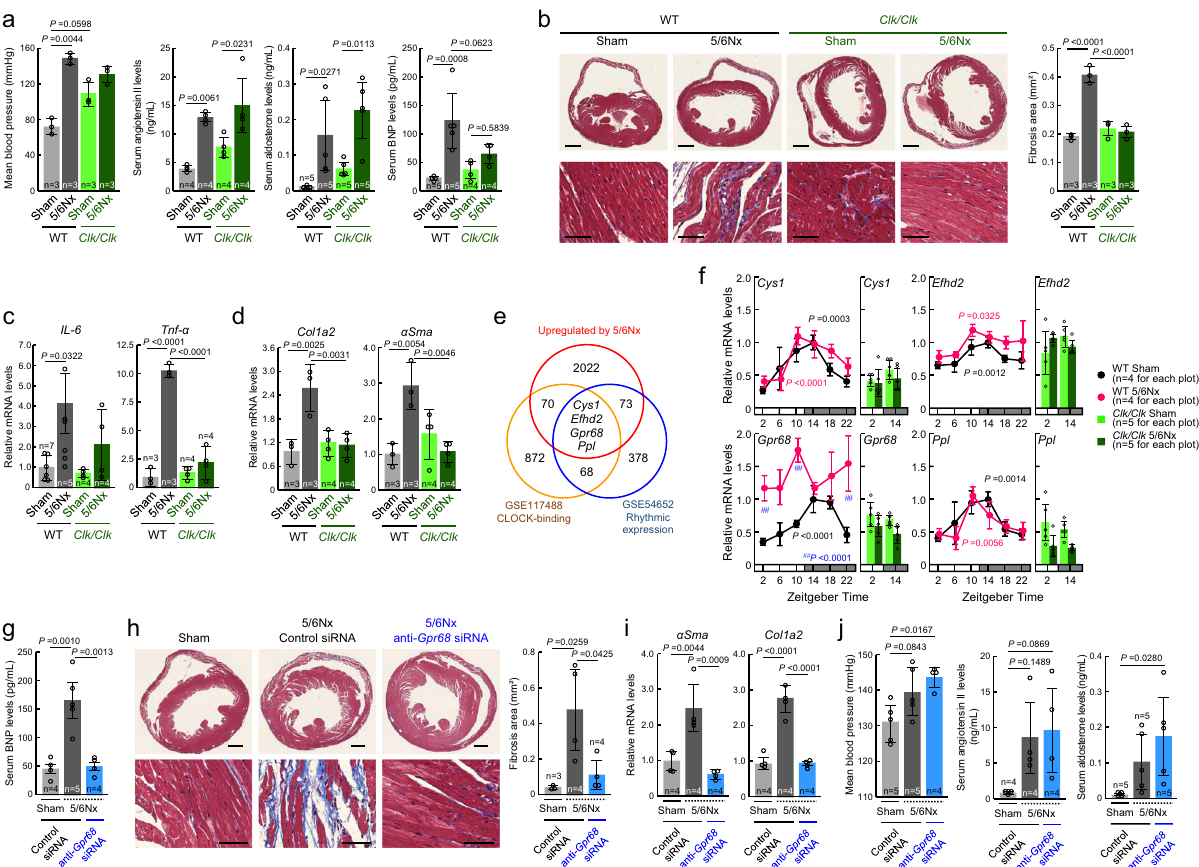
Fig. 1 Mutation of Clock gene suppresses cardiac complications in 5/6Nx mice. a Blood pressure and serum concentrations of angiotensin II, aldosterone, and BNP in wild-type (WT) and Clk/Clk mice with 5/6Nx. b Masson ’ s trichrome staining of fi brosis (blue) in the cardiac ventricle of WT and Clk/Clk mice with 5/6Nx. The right panel shows the quanti fi cation of the fi brosis area under light microscopy. c , d The mRNA levels of IL-6 , Tnf α , Col1a2 , and α Sma in the cardiac ventricle of WT and Clk/Clk mice with 5/6Nx. The mean value of the sham-operated wild-type group was set as 1.0. e Identi fi cation of CLOCK- dependent 5/6Nx-induced genes in the mouse heart. Three criteria were set to identify the genes as described in the “ Results ” and experimental procedure sections. f Temporal expression pro fi les of Cys1 , Efhd2 , Gpr68 , and Ppl in the cardiac ventricle of WT and Clk/Clk mice with 5/6Nx. The mean peak value